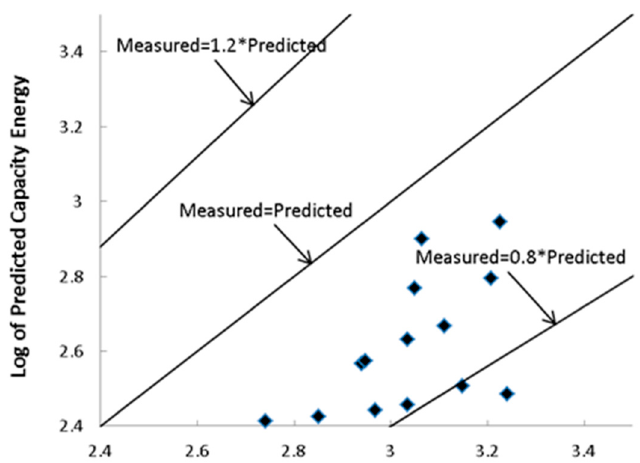
Figure 4. Capacity energy predicted by RSM equation on the basis of the half central composite (HCC) design of experiment (DOE) and the first ANN model versus the measured values of laboratory tests.